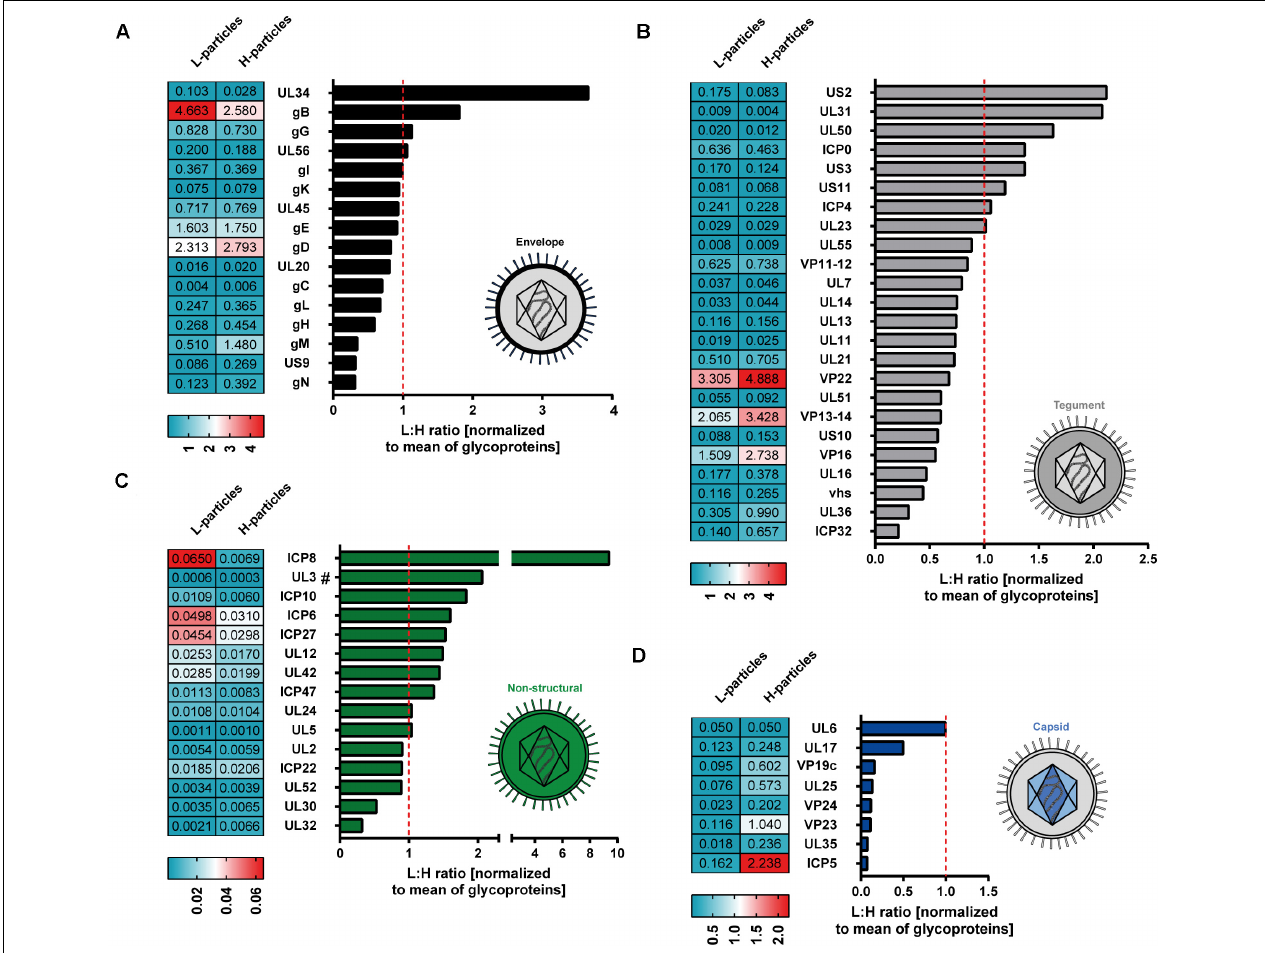
FIGURE 3 | Mass spectrometry-based comparative analysis of HSV-1-derived L-particles versus H-particles from infected BHK21 cells. HSV–1-derived H- and L-particles from supernatants of infected BHK21 cells were isolated for subsequent mass spectrometric analysis. The results of all four replicates are shown as relative ratio of L- versus H-particles using the respective protein intensity normalized to the mean intensity of all detected glycoproteins. Proteins are grouped according to their annotation as envelope (A) , tegument (B) , non-structural (C) or capsid proteins (D) and ordered regarding their ratio. The dashed red line represents a ratio of 1. UL3 was detected in two out of three samples and is marked with “#.” The values in the heat maps represent the average intensity of each detected protein among different samples, normalized to the mean of all detected glycoproteins, in the respective samples. Normalized values were separately calculated for L- and H-particle